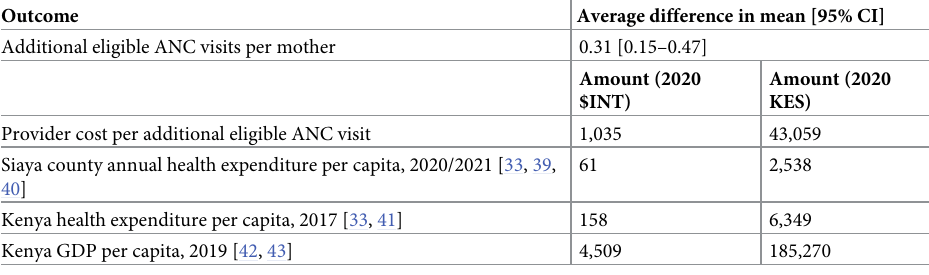
Table 4. Intervention outcomes and cost-effectiveness